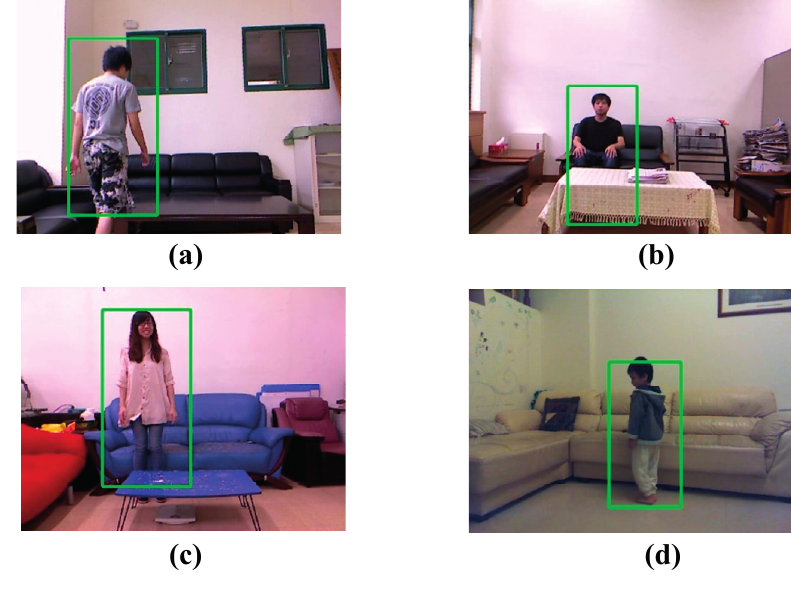
Figure 11. Example images captured in four living rooms in different